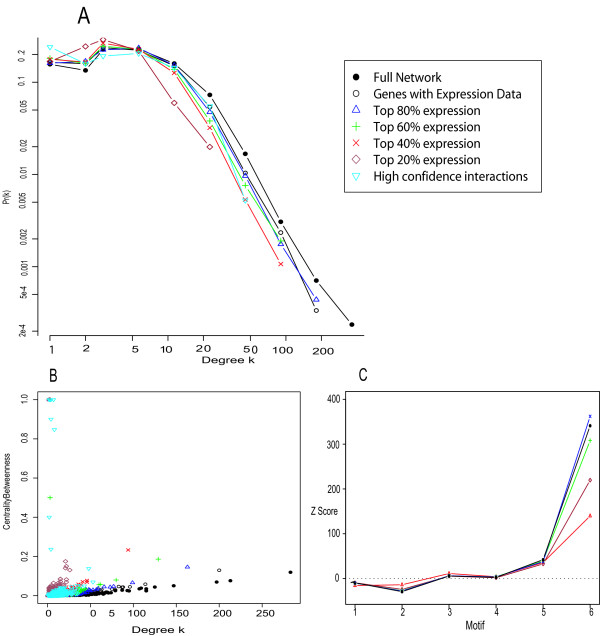
Properties of the yeast protein interaction networks under non-random sampling. (A) Degree distributions for proteins with different expression levels and a subnet generated from interactions which have previously been assigned as more reliable. (B) Betweenness-centrality for the same subnets. (C) Z-score of each of six different 4-motifs for the full network and each subnet sampled according to expression level, as well as the network consisting of high-confidence interaction data.